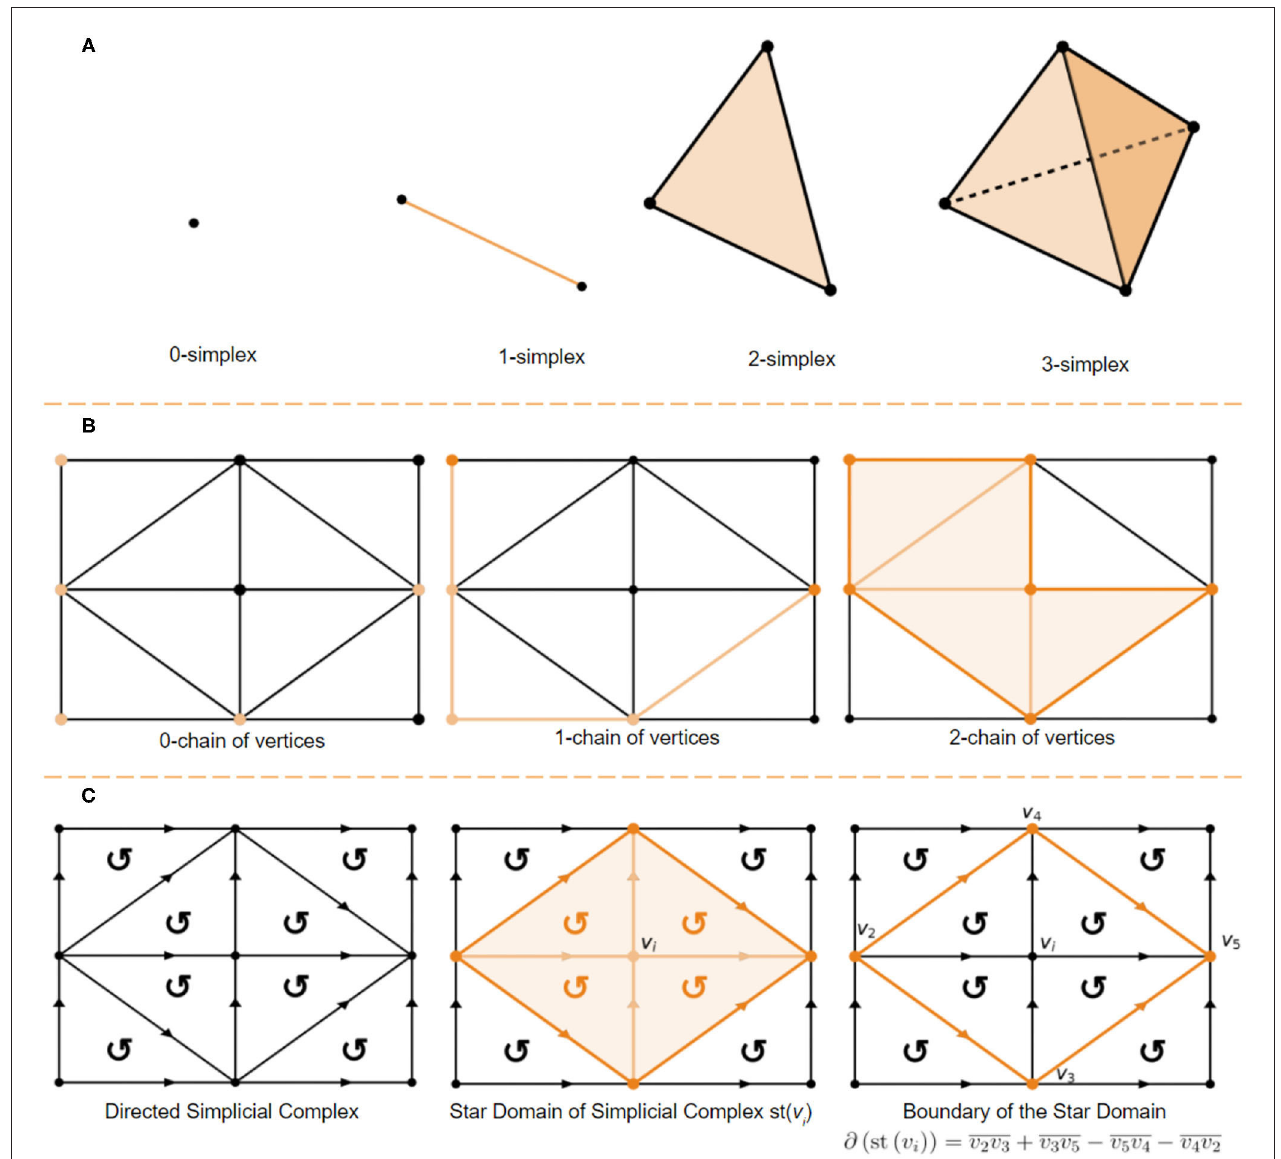
FIGURE 1 | (A) 0-simplex (point), 1-simplex (edge), 2-simplex (triangle), and a 3-simplex (tetrahedron). (B) 0-chain of vertices, a 1-chain of edges and a 2-chain of simplices. (C) Directed 2-simplex in the directed simplicial complex (left), star domain defined by st ( v i ) (center), and it’s boundary defined